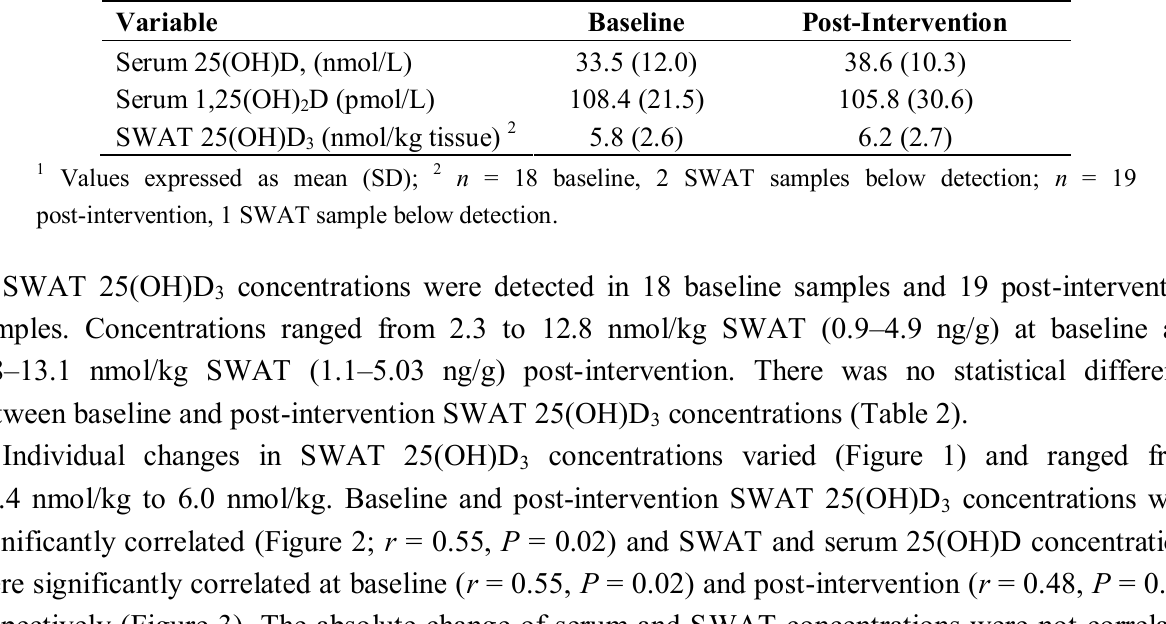
Table 2. Serum and Subcutaneous White Adipose Tissue concentrations of 25(OH)D and 1,25(OH) D at Baseline and Post-Weight Loss Intervention in adults 1 2